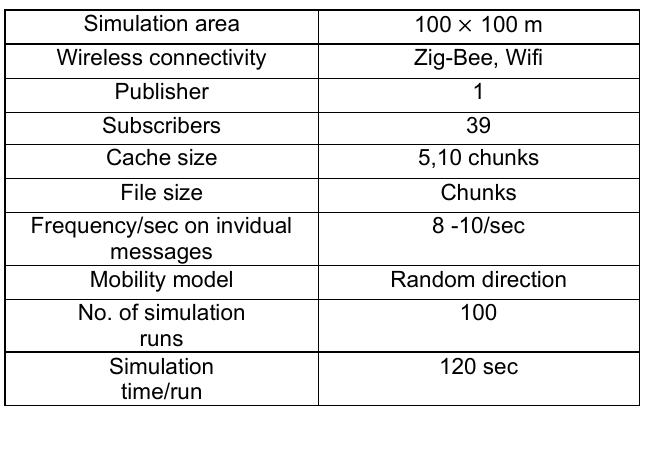
Figure 5. Comparison between the bandwidth consumption and number of nodes Figure.5 illustrates the comparison performed between the bandwidth consumption and number of nodes of the novel CBAD and the already available KBCR, LSED methods. It is concluded that the proposed CBAD yields much better bandwidth consumption in comparison with the available KBCR, LSED methods.